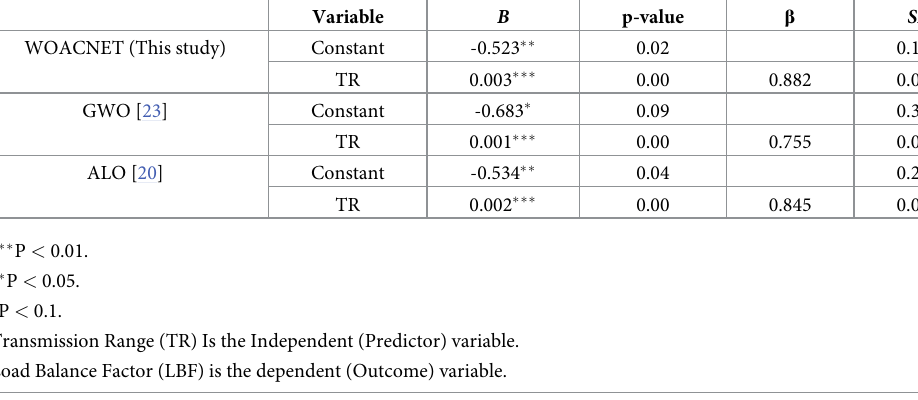
Table 5. Regression coefficients of transmission range on load balance